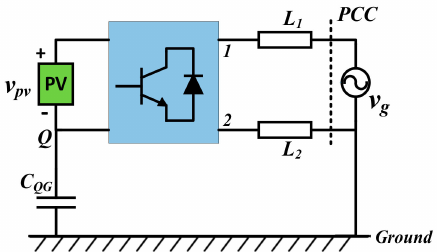
Figure 1. Typical single-phase grid-connected PV